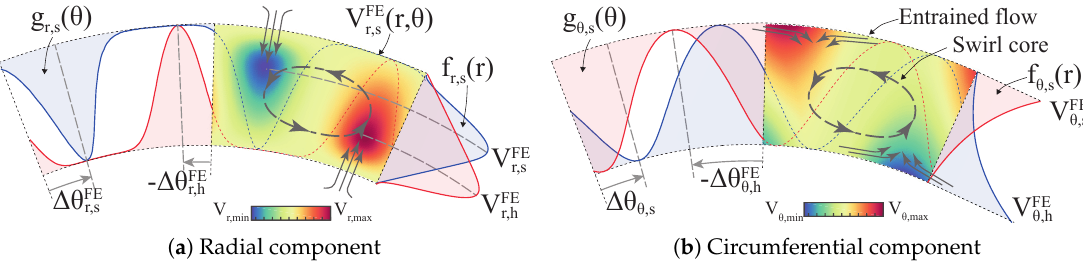
Figure A1. Modelling of entrained flow